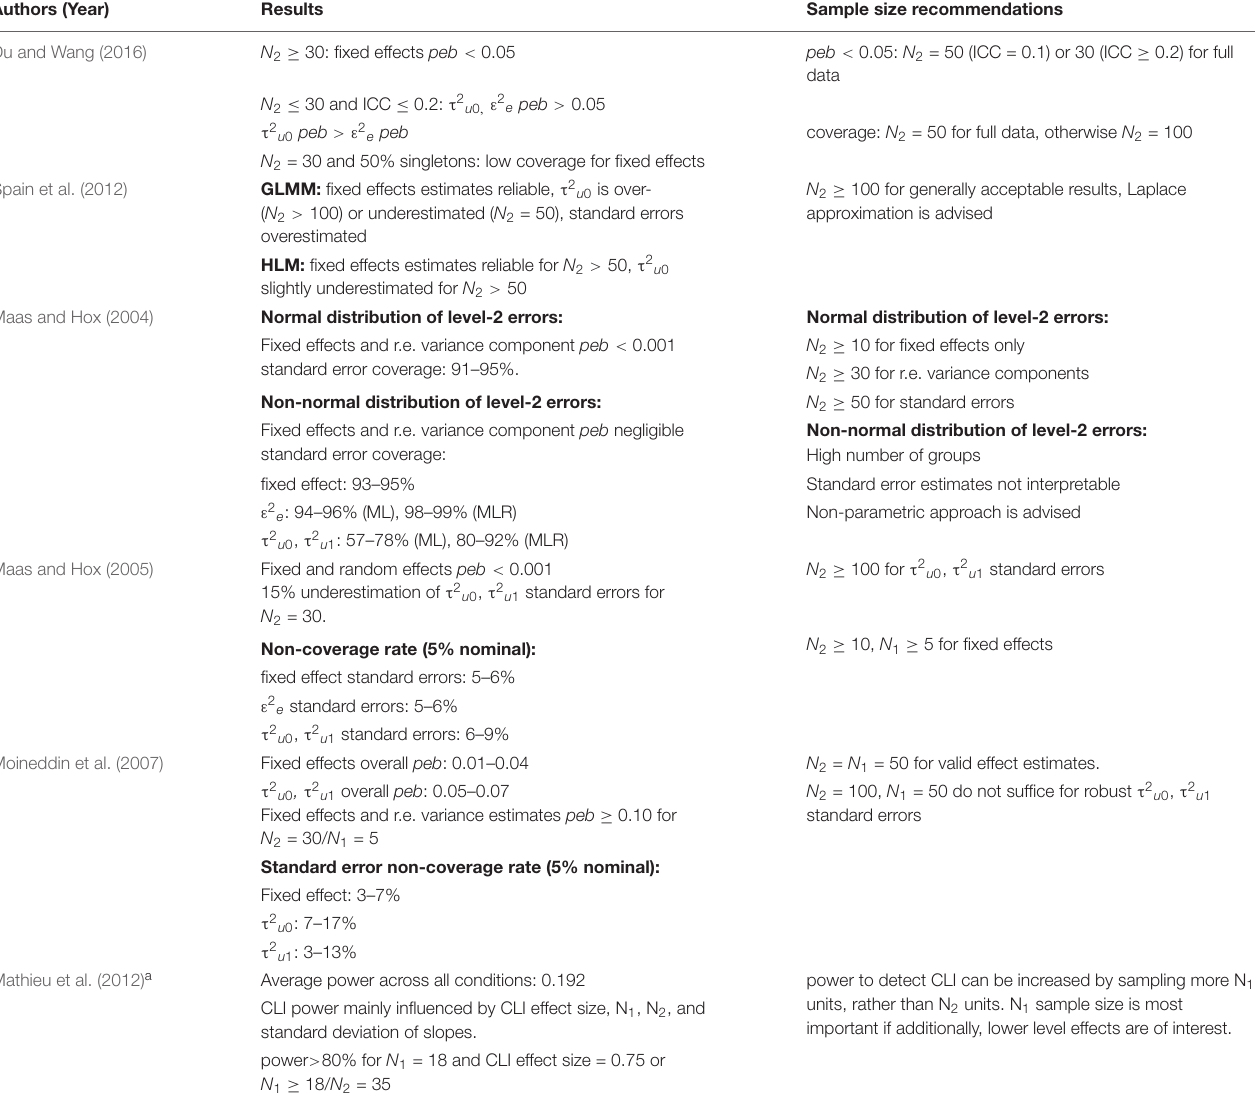
TABLE 3 | Selected results and recommendations of studies examining the impact of sample sizes on estimation results in two-level